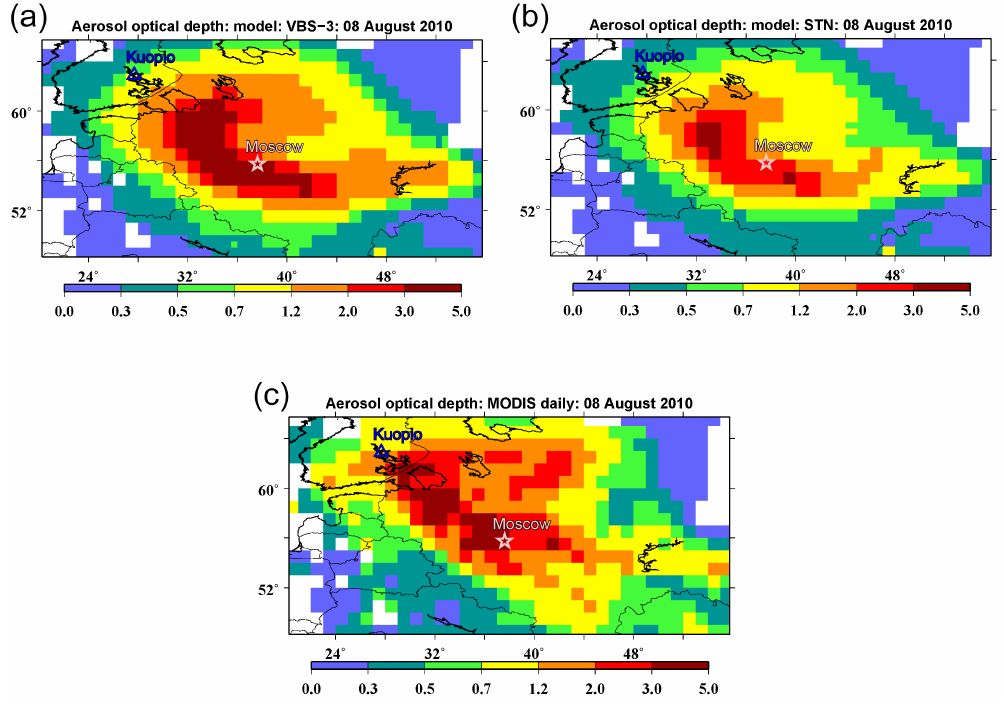
Figure 8. Spatial distributions of AOD at 550nm on 8 August 2010 according to simulations for scenarios VBS-3 (a) and STN (b) in comparison with the MODIS measurement data (c) .